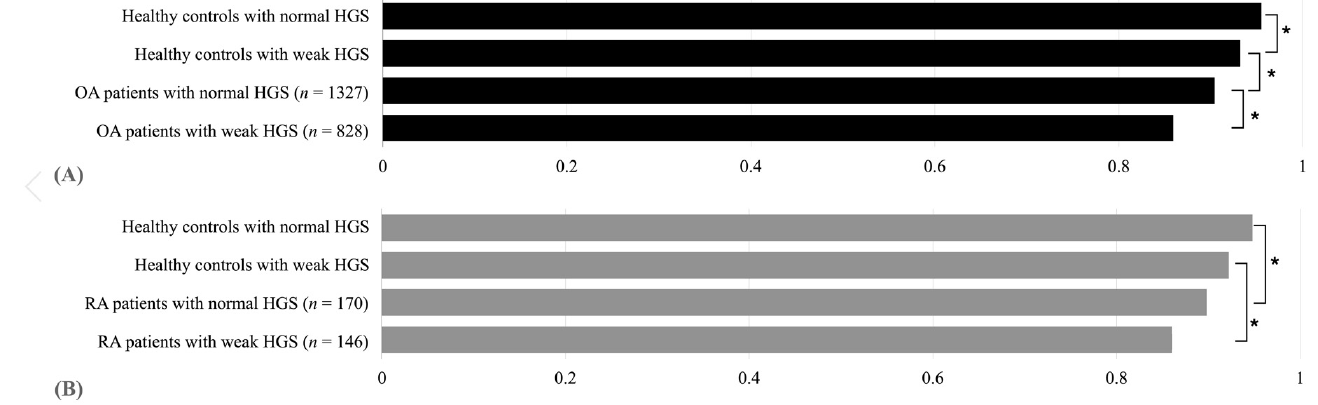
index according to HGS in RA patients (Figure 3). Table 3. Comparisons of EQ-5D index depending on HGS in patients with arthritis and healthy controls.